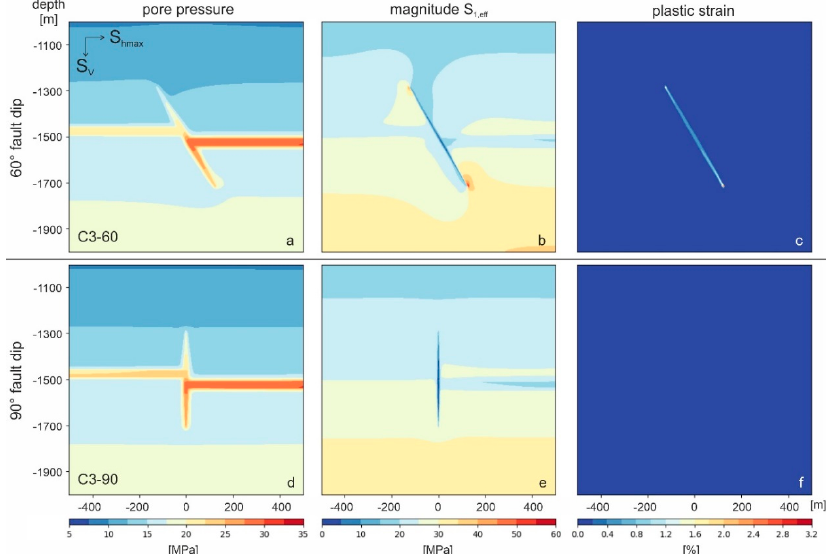
Figure 14. Results after the last load step for a 3-element wide fault zone with embedded in a curvilinear grid with different fault dips. 60°-fault dip: ( a ) pore pressure. ( b ) magnitude of S 1,eff . ( c ) grid with di ff erent fault dips. 60 ◦ -fault dip: ( a ) pore pressure. ( b ) magnitude of S 1,e ff . ( c ) total von Mises total von Mises plastic strain. 90°-fault dip: ( d ) pore pressure. ( e ) magnitude of S 1,eff . ( f ) total von Mises plastic strain. 90 ◦ -fault dip: ( d ) pore pressure. ( e ) magnitude of S 1,e ff . ( f ) total von Mises plastic plastic strain.